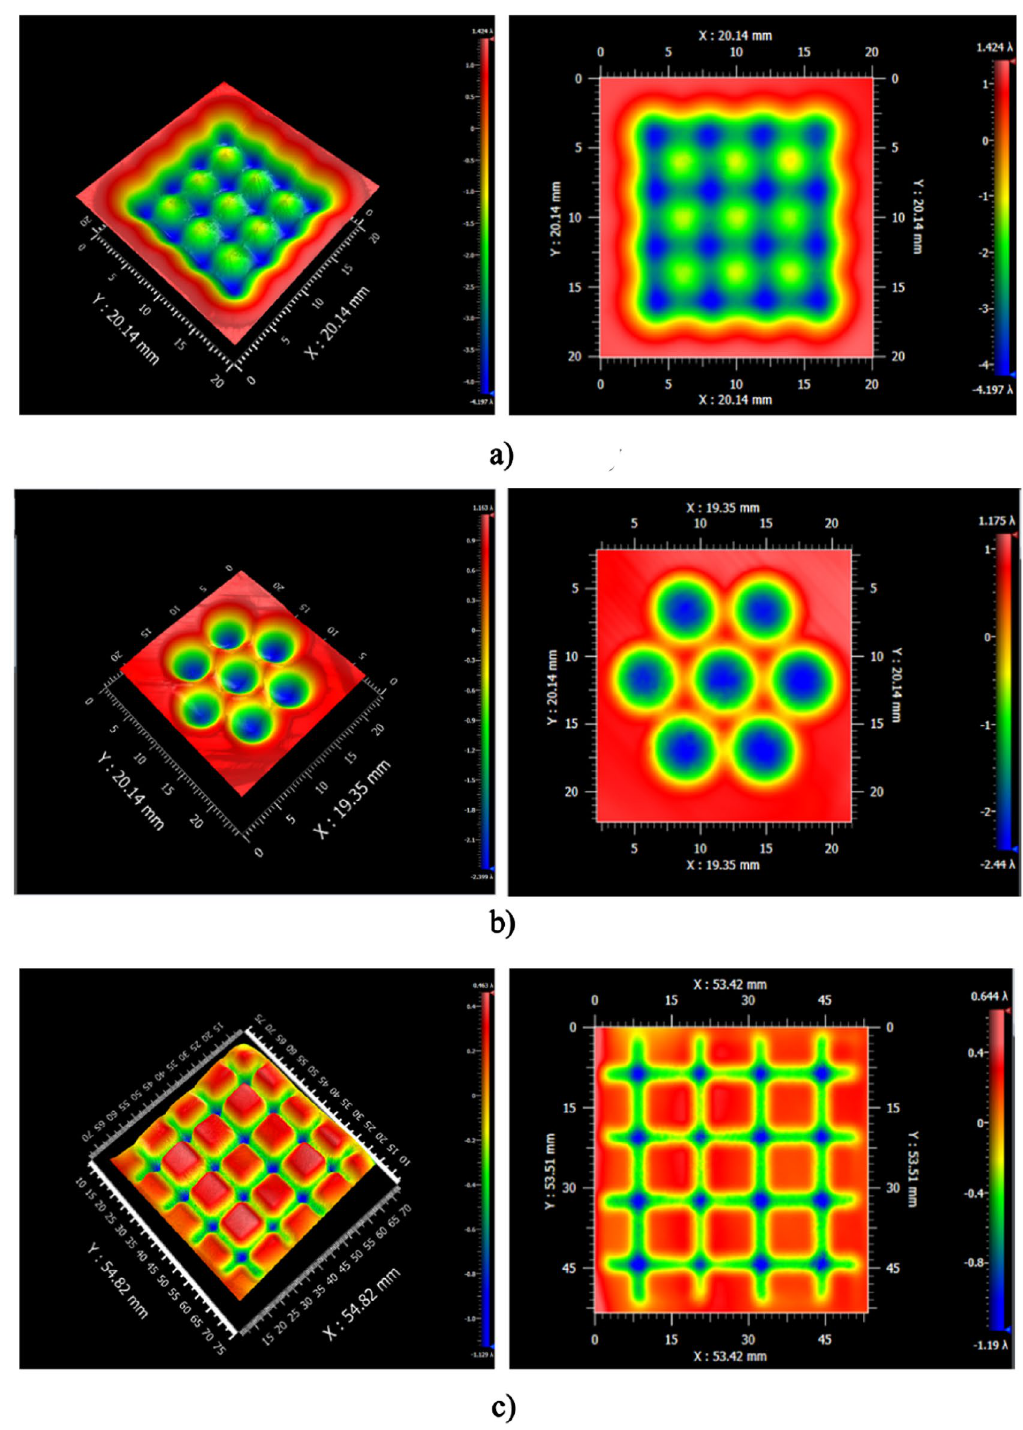
Figure 14. Discrete APPS experiment results: ( a ) Square lens array ( b ) Hexagon lens array ( c ) Groove